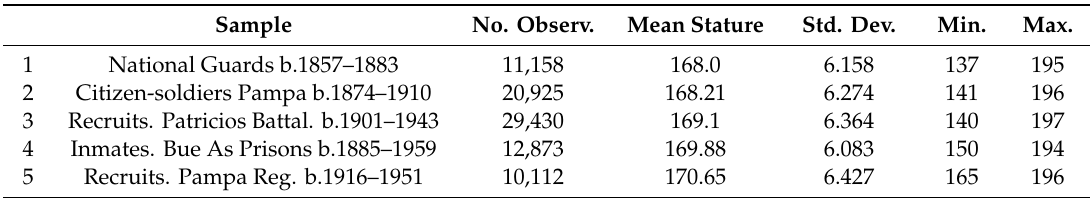
Table 1. Five samples: basic